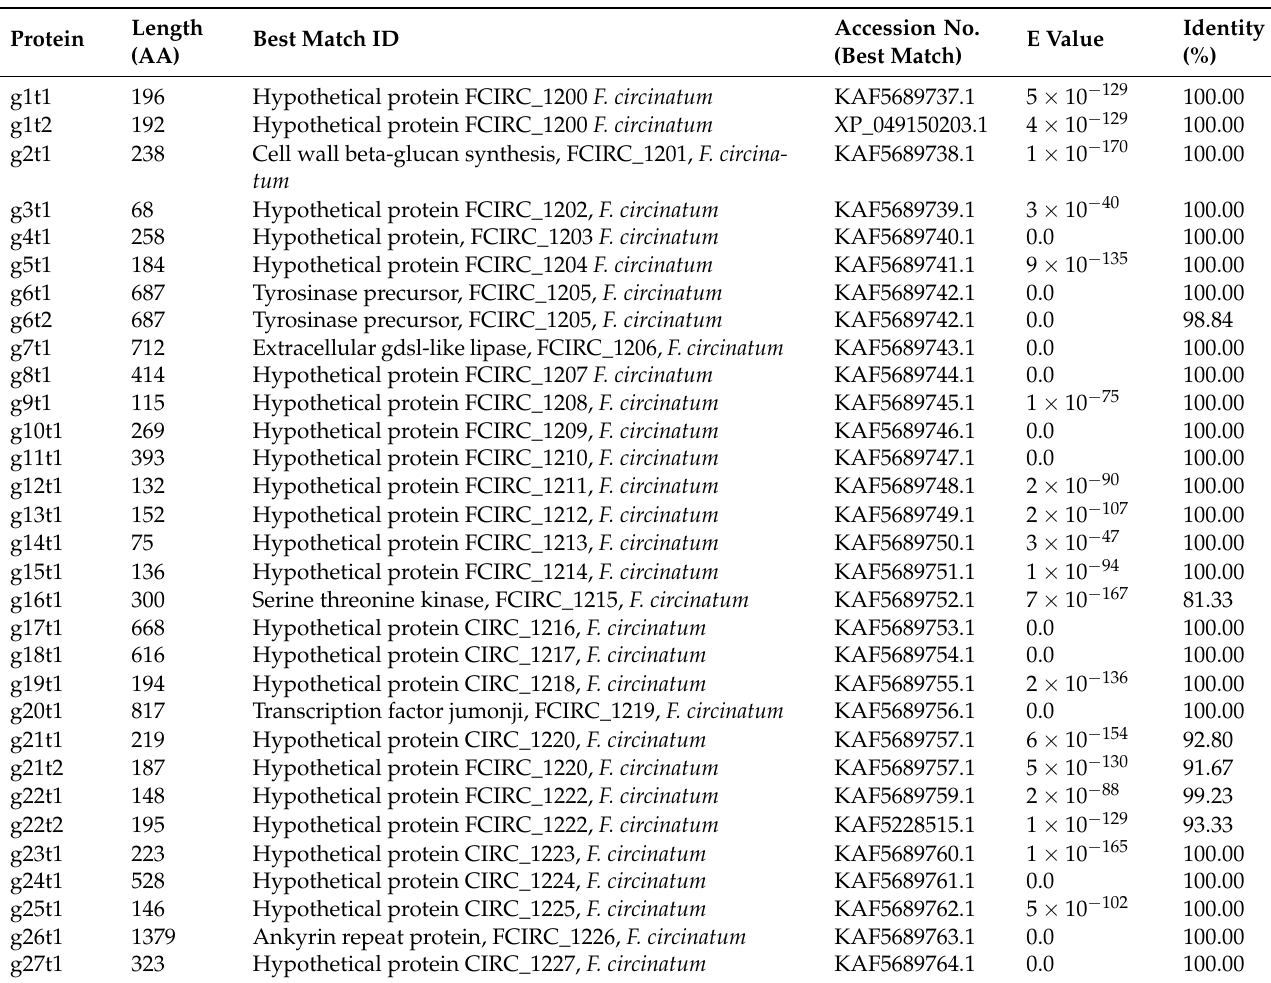
Table A2. GenBank best matches of putative F. circinatum